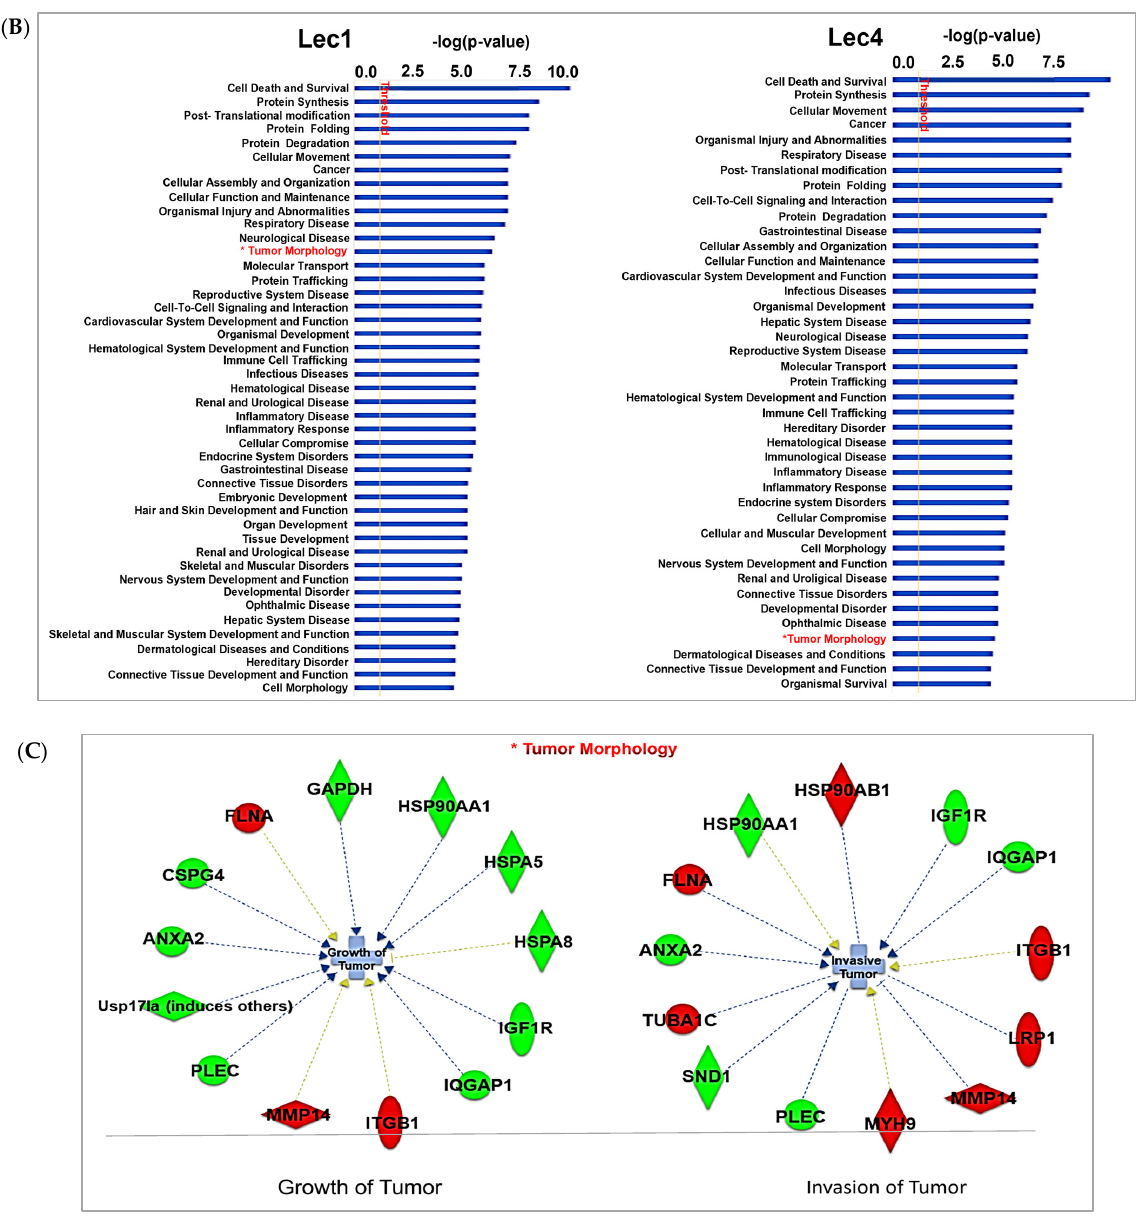
Figure 4. Ingenuity Pathway Analysis (IPA, https://www.qiagenbio-informatics.com/products/ ingenuity-pathway-analysis/ (accessed on 30 April 2021)) of the differentially expressed proteins revealed top canonical pathways and downstream disease and biological pathways between control CHO and Lec1/Lec4 cells. ( A ) Top 11 enriched canonical pathways according to Ingenuity Pathway Analysis core analysis are shown here. The -log ( p -value), z-score, and ratio of the top 11 significantly activated canonical signaling pathways are listed. A scale from light blue to dark blue indicates the level of activation of the canonical signaling pathways. The straight orange vertical line running through the bars is the p -value threshold for a particular pathway’s enrichment. The horizontal axis is the –log ( p value) and the vertical axis represents the given pathways. ( B ) Bar graphs illustrate the disease and disorder enrichment in Lec1 and Lec4 based on the “ p -value of overlap” of the proteins in our dataset relative to the IPA’s predefined categories. The -log values ( p -values) of the top 45 significantly involved diseases and functions are listed for Lec1 and Lec4 cells. ( C ) Significant upregulated and downregulated proteins which influence tumor growth and invasion from the list of pathways involved in diseases and disorders in Lec1 cells are